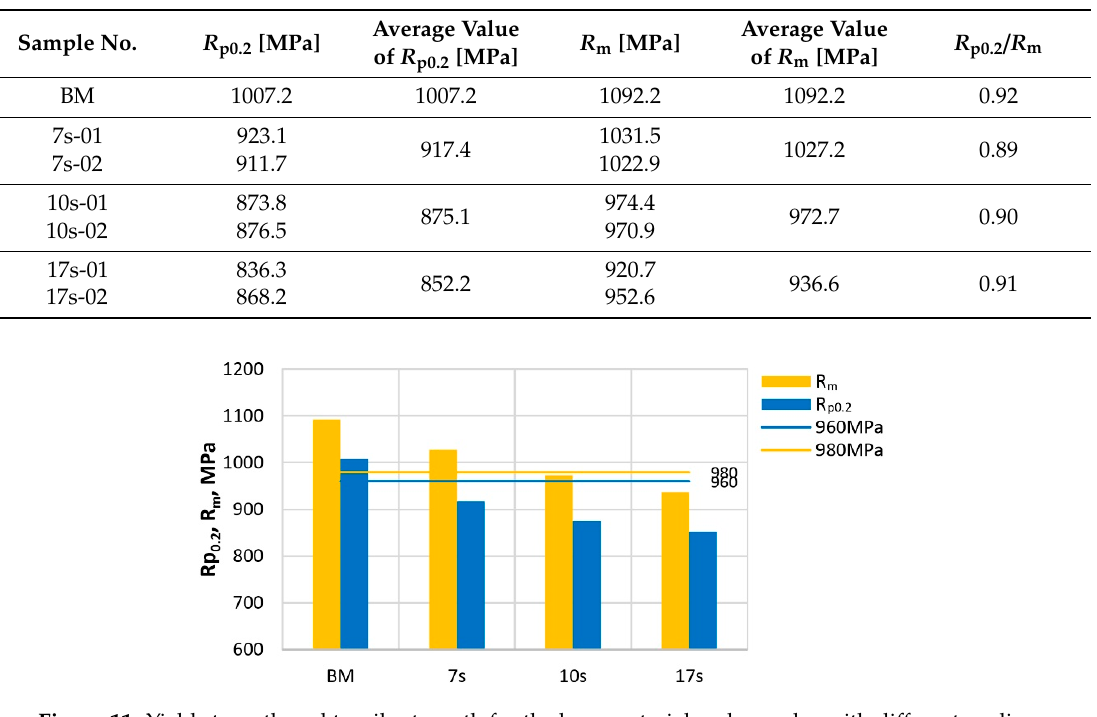
Table 4. Results of the Charpy pendulum impact test (at the temperature of − 40 °C) for the base material and samples affected by the thermal cycle under different cooling times t 8/5 .